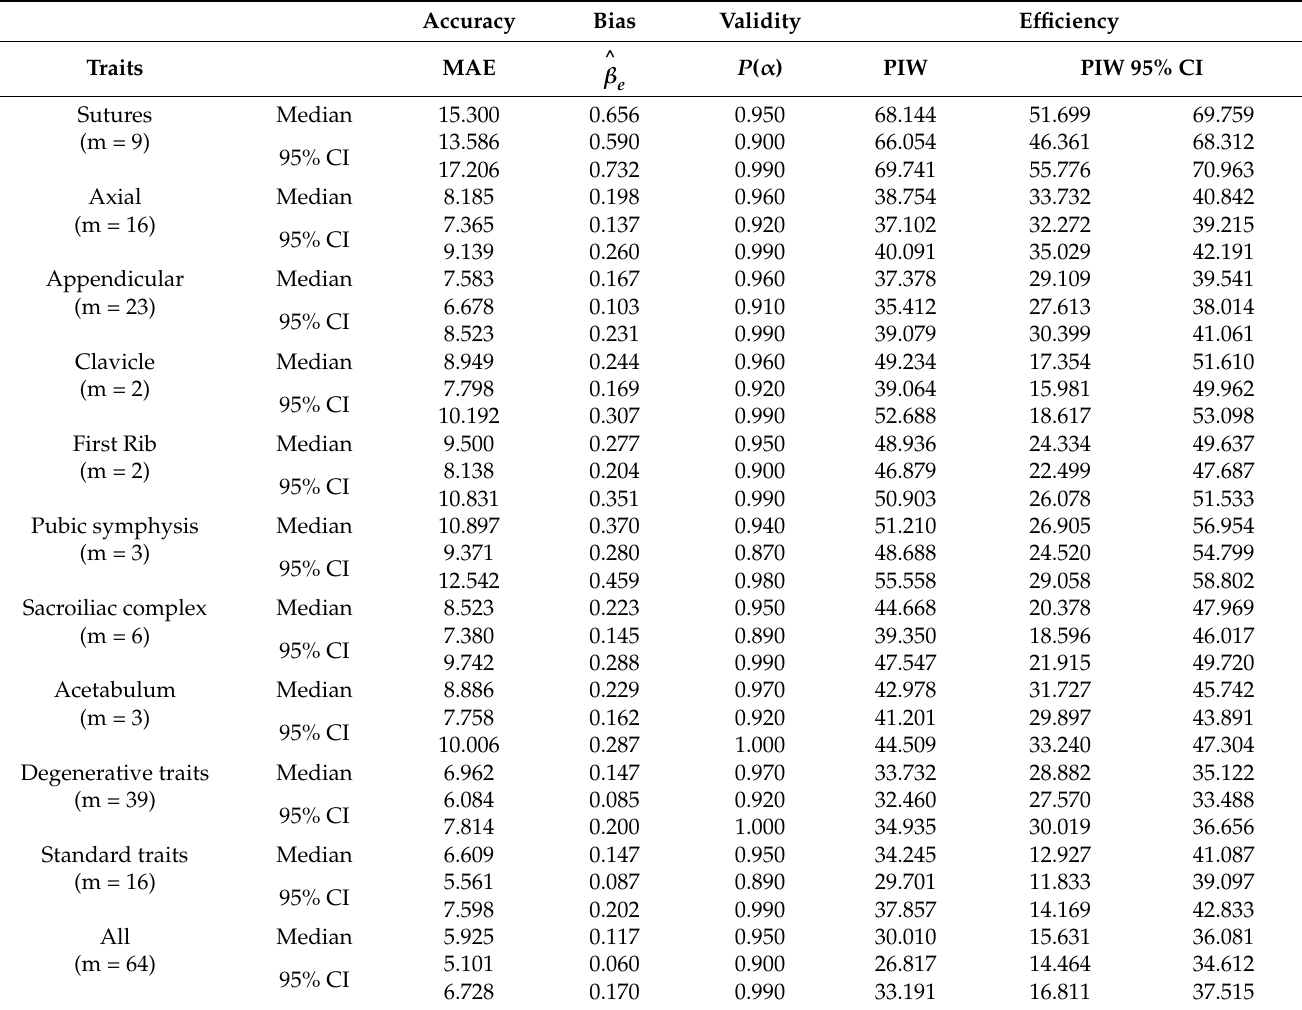
Table 2. Monte Carlo cross-validation metrics for DRNN models built on pre-specified skeletal traits sets.